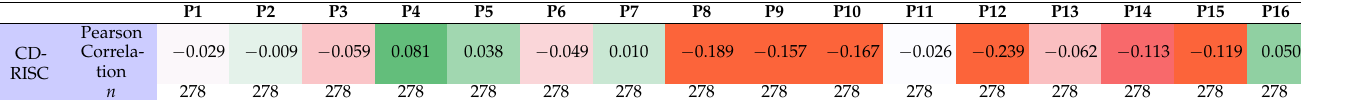
Table 2. Correlation between meaning-giving through social/collective resilience factors and general health. Family Friends Pearson Correla- 0.027 0.044 0.045 0.048 − 0.020 General tion health n 278 278 278 278 278